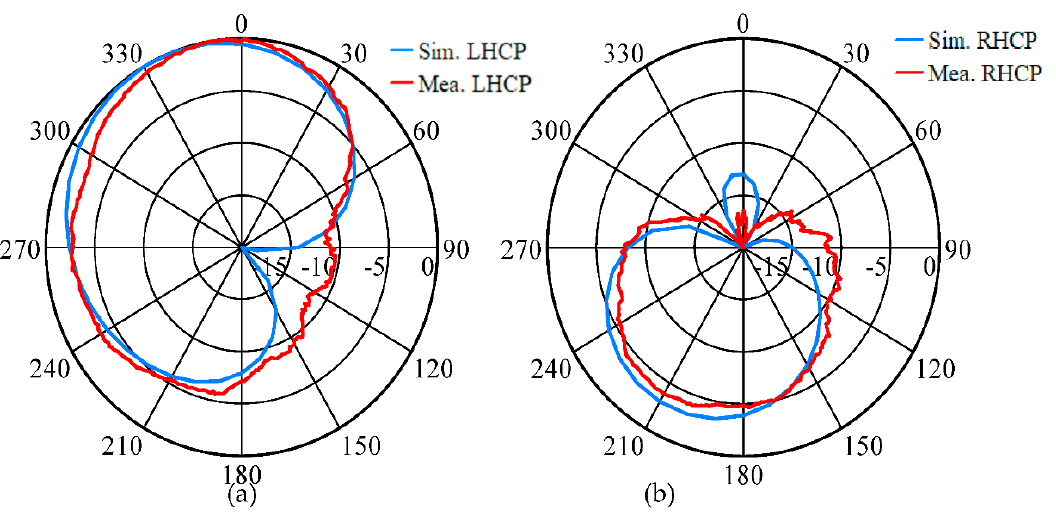
Figure 7. Radiation pattern @ 9.0 GHz. ( a ) Left-handed circular polarization (LHCP) (xz-plane) and ( b ) right-handed circular polarization (RHCP) (xz-plane).